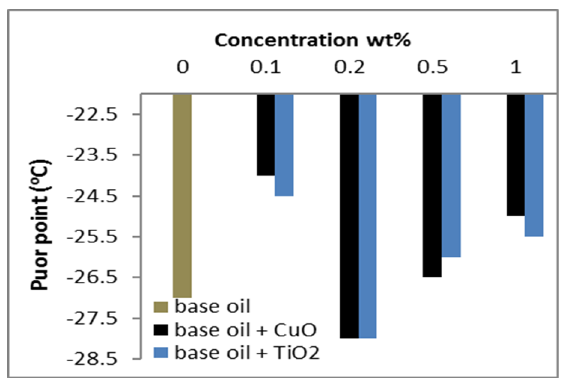
Fig. 10. The pour point values of parent oil and